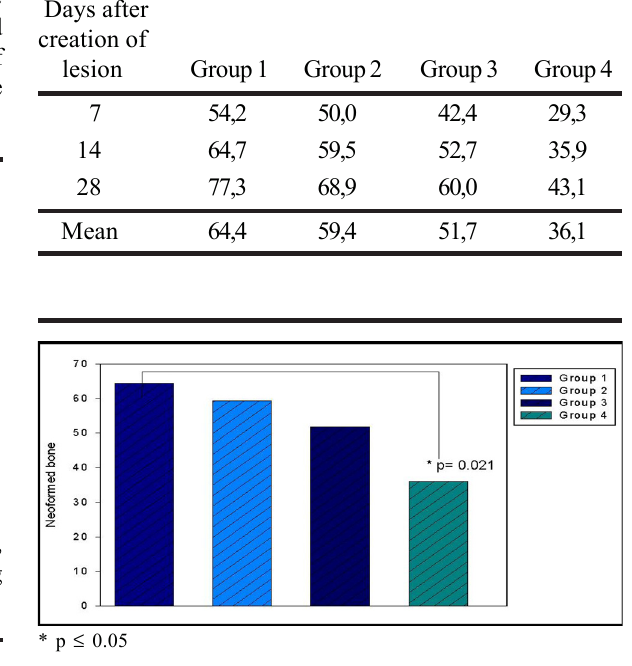
FIGURE 2 - Graph comparing the four groups and their respective standard deviations relating to mean bone neoformation